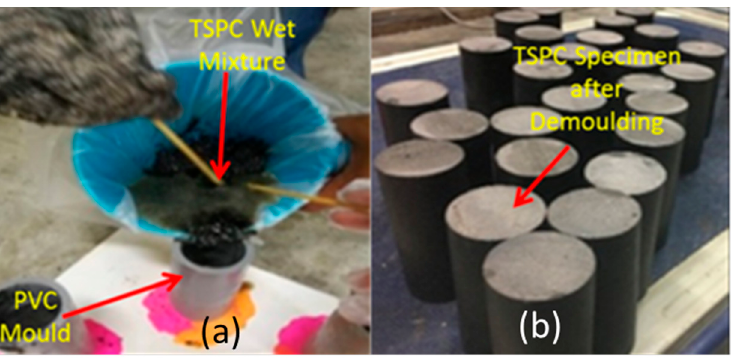
Figure 1. TSPC column specimen preparation. ( a ) Casting wet mixture of TSPC into specimen mould. ( b ) TSPC specimen after demoulding.